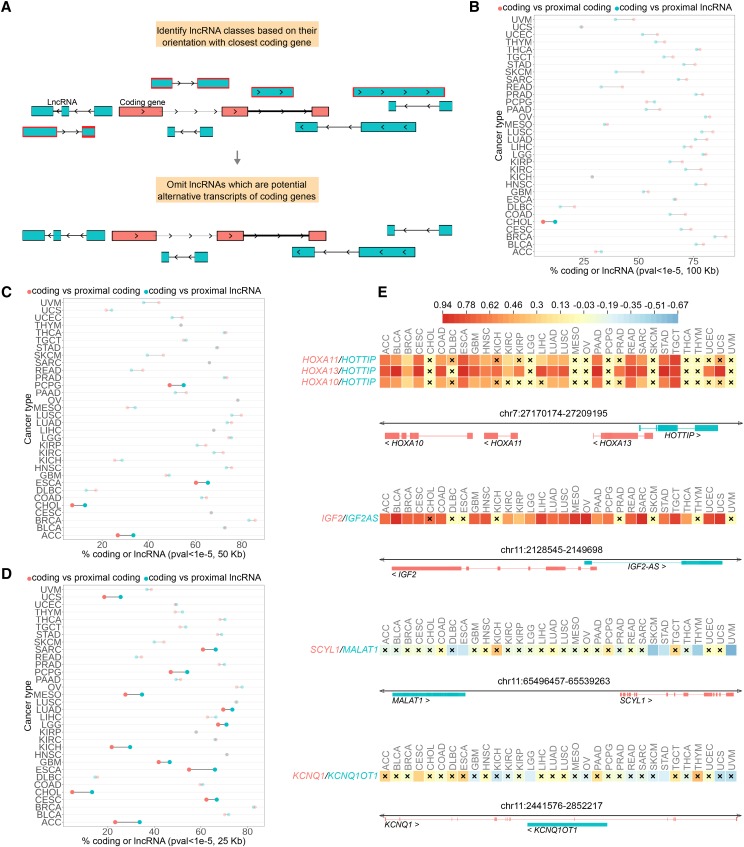
General statistics of coding/coding and lncRNAs/coding correlations at several genomic distance thresholds along with specific examples. A) Classification of lncRNAs based on their orientation with respect to a flanking coding gene. LncRNAs marked in red might be potential alternative polyadenylation events of coding genes and are hence removed from downstream analyses. B-D) Enrichment of lncRNAs for significant correlations with proximal coding genes at different genomic distance thresholds: B) 100 Kb C) 50 Kb D) 25 Kb. Cancer types where the fraction of lncRNA-coding proximal pairs that show significant correlation is significantly enriched compared to control sets of coding-coding pairs are indicated by larger dots (Fisher’s exact test, P < 0.01). E) Examples of known lncRNAs-coding regulatory interactions that are also confirmed by the correlative analysis. Each box represents the estimated spearman correlation coefficient between the coding gene and the lncRNAs in a given cancer type. The colors correspond to the values depicted in the scale. Crosses indicate correlations at P > 1e-5.